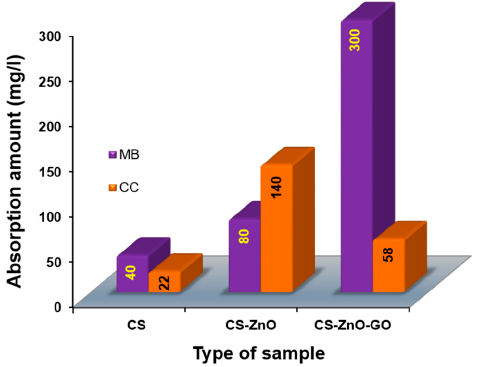
Figure 7. Comparison of adsorption amounts of methylene blue (MB) and chromium complex (CC) dyes by CS and the hybrid structures with a contact time of 20 min.